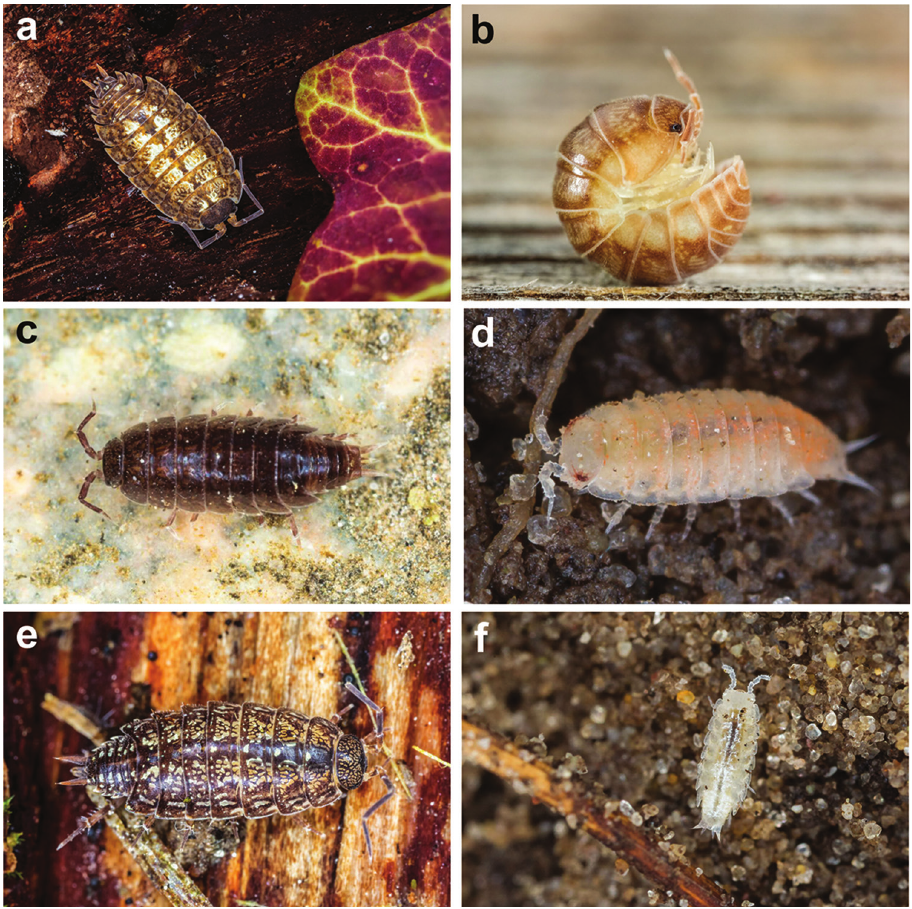
Figure 5. Six of the nine species added to this new checklist, a Porcellio monticola b Eluma caelata c Hylo- niscus riparius d Trichoniscoides sarsi e Philoscia affinis and f Metatrichoniscoides leydigii ; photos: Gert